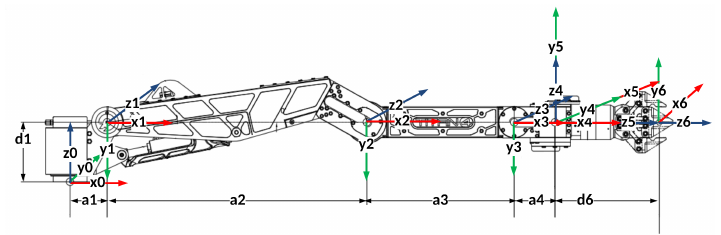
Figure 4. Kinematic model of a Schilling Titan 2